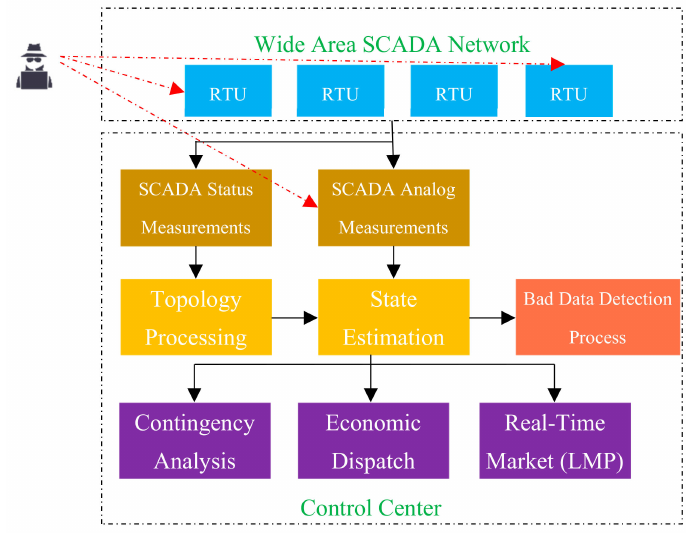
Figure 1. Various strategies of false data injection attacks (FDIAs) on power system state